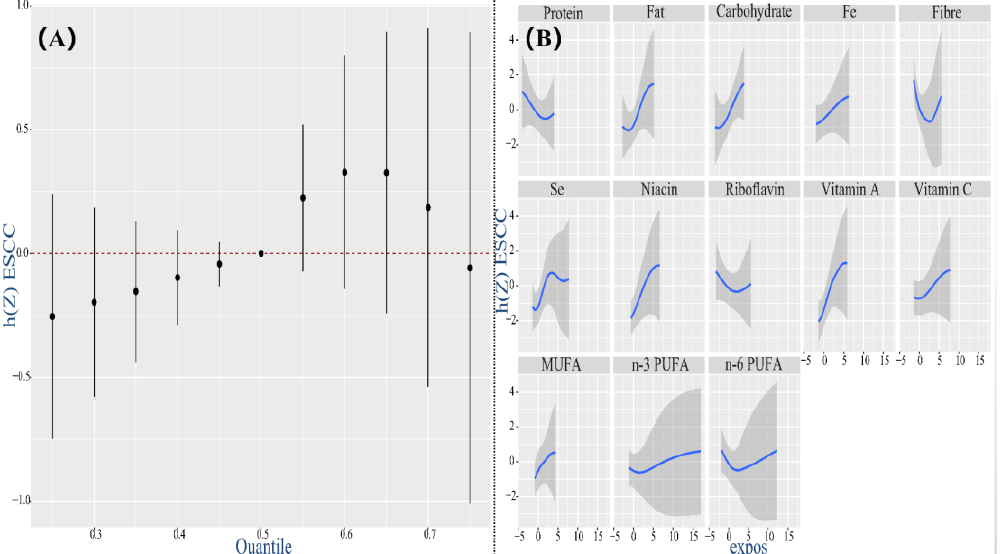
Figure 3. Associations between 13 dietary nutrients (predictors) and ESCC (outcome) by BKMR model adjusting for age, gender, education, income, occupation, tobacco smoking, drinking intensity, tea consumption, eating speed per meal and hot food. ( A ) The estimated overall effect of 13 dietary nutrients as compared to when all other nutrients are at the 50th percentile. The red dotted line means the reference level at which all of nutrients are fixed to their 50th percentile, to achieve interests of computing the overall effect of the mixture. ( B ) The univariate exposure–response function of each nutrient when setting the remaining nutrients at their median level. Abbreviation: BKMR, Bayesian kernel machine regression. Whereas the overall effect of whole nutrients tended to be pro − inflammatory, it was inappropriate to take all pro − inflammatory and anti − inflammatory predictors at the same time into account since there might be an offset influence. Hence, we further investigated respective effects and possible relationships with ESCC for each subset’s pro − and anti − inflammatory